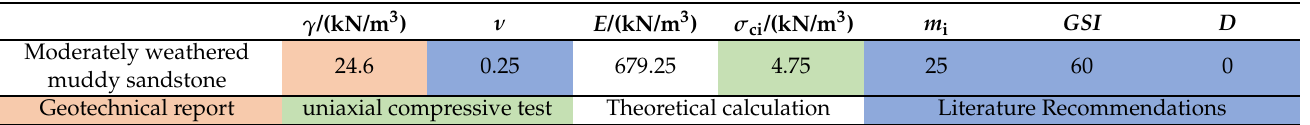
Table 5. Parameters in the HSS